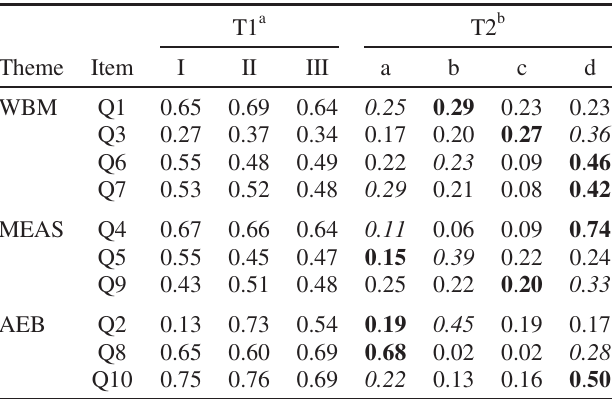
TABLE IV. Frequencies of subjects ’ answers ( N ¼ 445 ) to